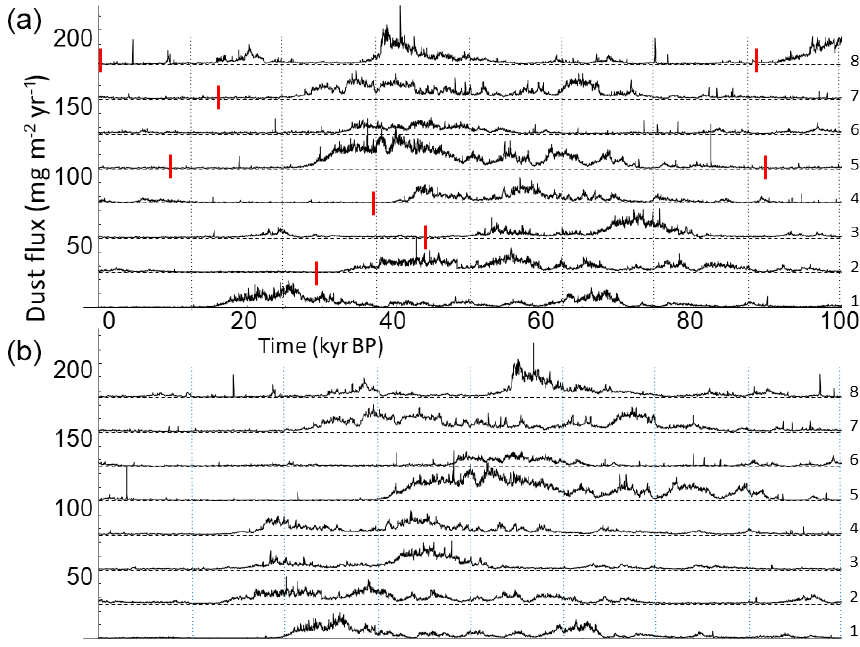
Figure 7. Panel (a) : successive segments of theoretical 100kyr long glacial cycles using usual (dimensional) time (present to past: bottom to top, the segment number is at the far right) with the 12.5kyr phases indicated by vertical dashed lines. The short red lines indicate the interglacial dust minima. Each glacial–interglacial cycle is shifted by 25 units in the vertical for clarity. The red markers in (a) are mapped to the first dashed blue line in (b) . Panel (b) : successive cycles using non-dimensional time (interglacial to interglacial) and then shifted by one phase to better line up with the usual time segments (the left-most phase of the bottom line of (b) is zeroed). The average (nominal) resolution is 25 years. The interglacial dust minima were taken as 128.5, 243.5, 336, 407.5, 490, 614, 700, and 789kyrBP, and the data start at 373yrBP. Each cycle is shifted by 25 units in the vertical for clarity. The data older than 789kyrBP were not used in these non-dimensional